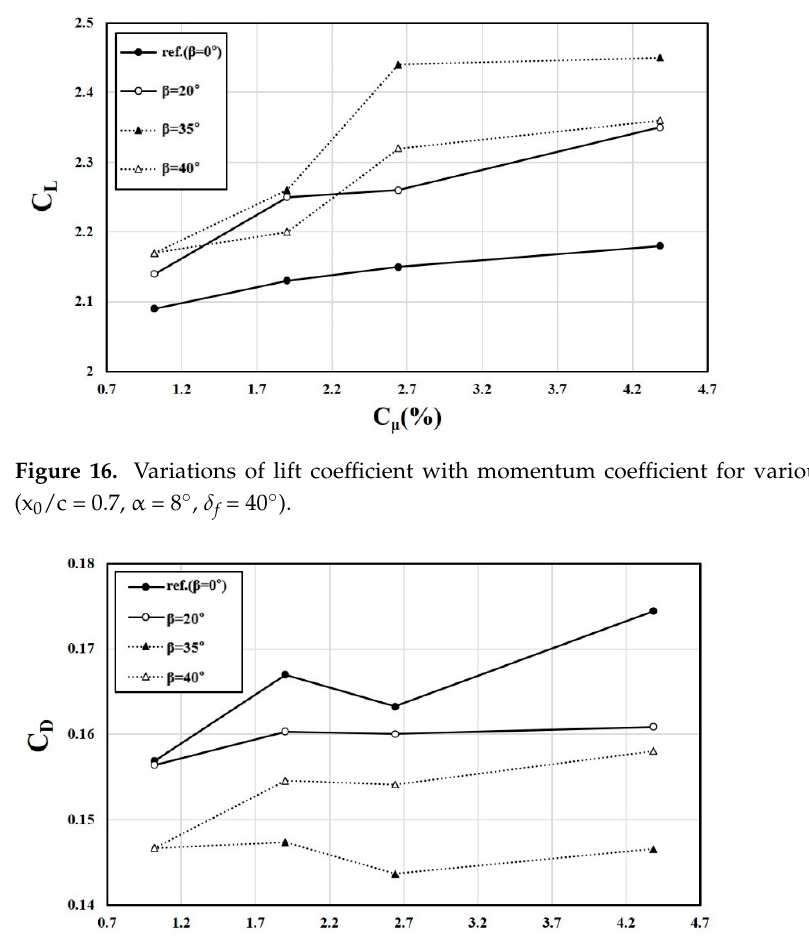
Figure 16. Variations of lift coefficient with momentum coefficient for various bending angles (x 0 /c = 0.7, α = 8°, δ f = 40°).